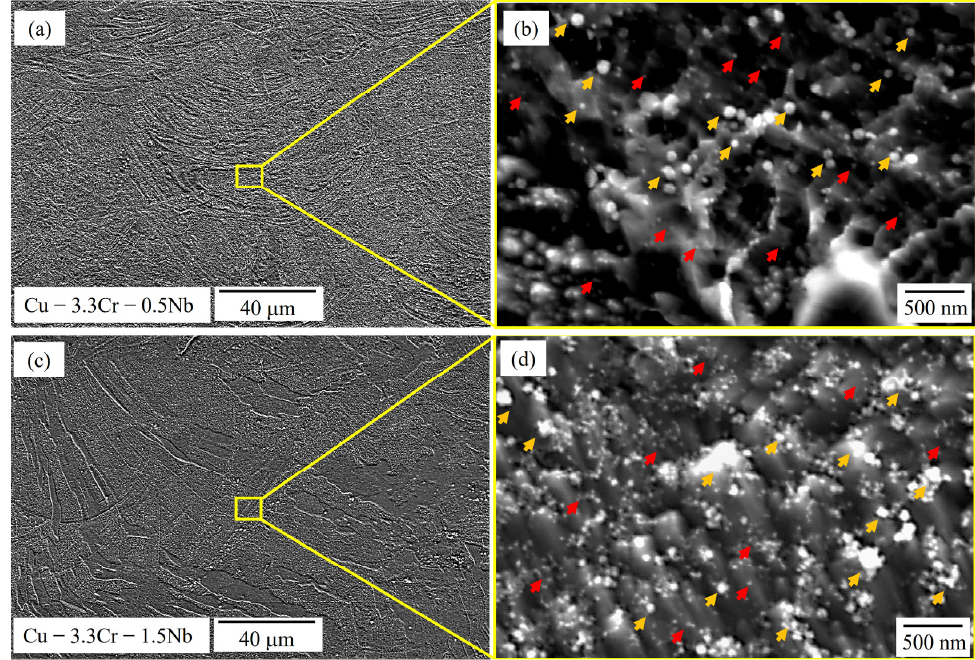
Figure 5. SEM images (SE mode) of Cu-3.3Cr-0.5Nb alloy in low ( a ) and high magnification ( b ) showing the presence of different precipitates (red and yellow arrows). SEM images (SE mode) of Cu-3.3Cr-1.5Nb alloy in low ( c ) and high magnification ( d ) showing the presence of different precipitates (red and yellow arrows). Table 4. Chemical composition (in wt.%) of unreinforced specimens determined by EDS. Values are averaged over 12 single-point measurements on occasionally found clusters or larger particles of the respective nanoparticle